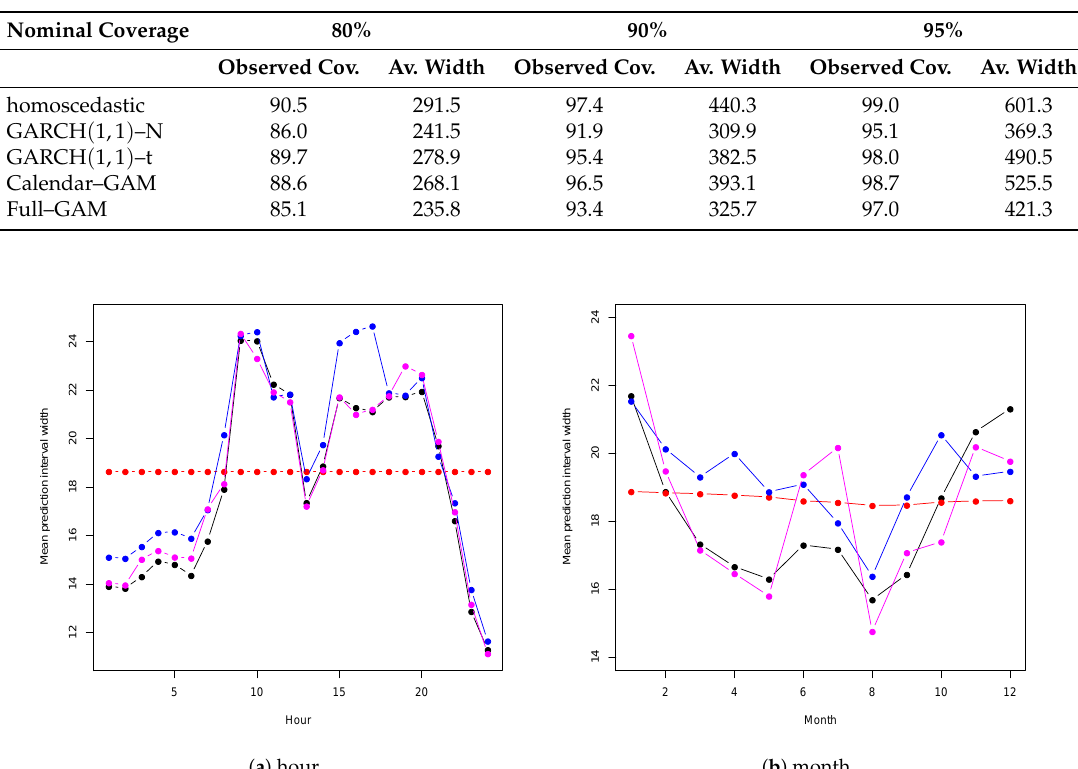
Table 9. Electricity demand for the southern zone. Out-of-sample predictive results for the year of 2019. For all of the models the MAE is equal to 65.25 MWh and MAPE is equal to 2.4%. Moreover, “observed cov.” stands for nominal coverage, and “av. width” is the mean interval forecasting width at the ( 1 − α ) level.